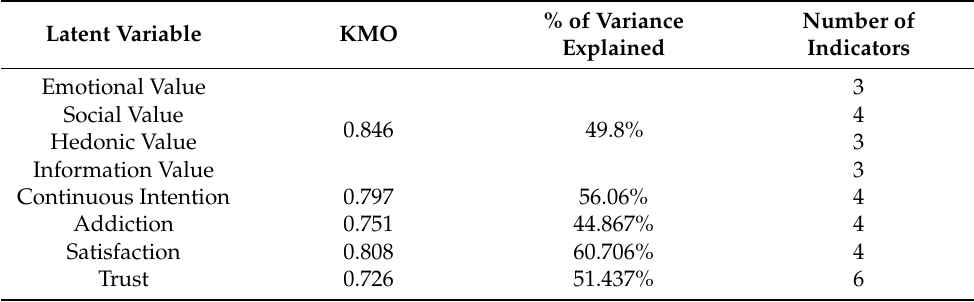
Table 4. Exploratory factor analysis